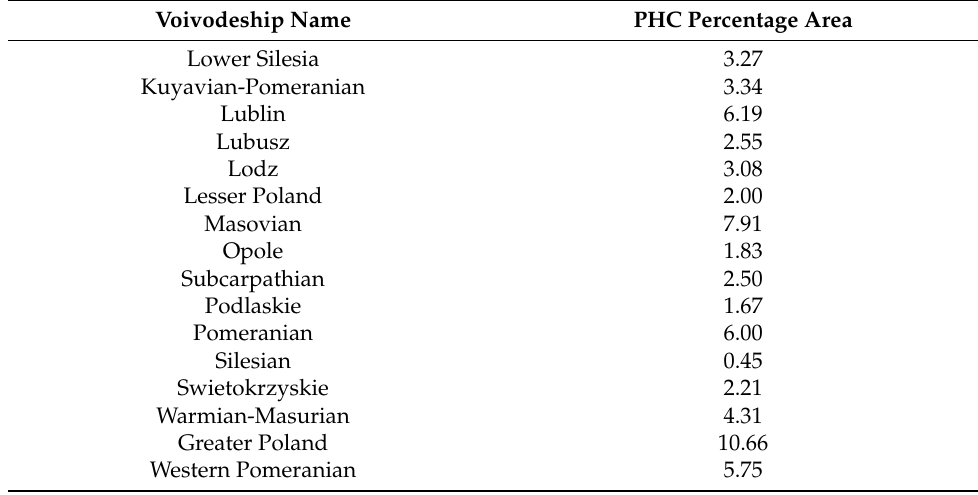
Table 5. Estimated percentage of the area of voivodeship with weaker access to PHC facilities in rural areas with population density above 20 people/km 2